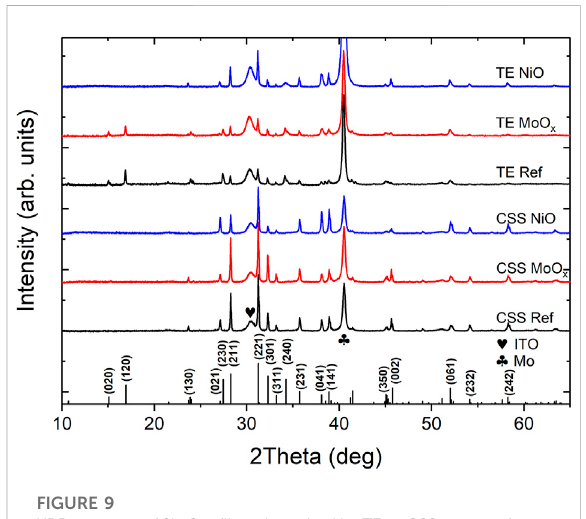
FIGURE 9 XRDpatternsofSb 2 Se 3 fi lmsdepositedbyTEorCSSontopof NiO, MoO x and Mo-coated